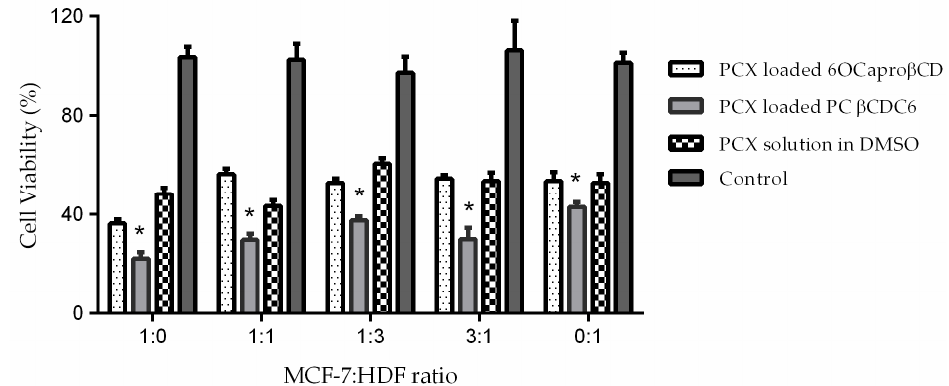
Figure 9. Antiproliferative effect of PCX loaded amphiphilic CD nanoparticles on MCF-7: HDF co-culture ( n = 6, ±SD) * p < 0.05 compared with PCX solution.